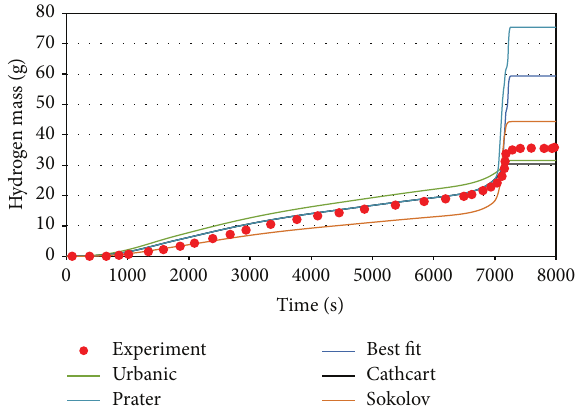
Figure 17: QUENCH-06 test calculation using ASTEC code. Fuel rod imitator cladding temperature in outer ring of bundle at 350 mm height.